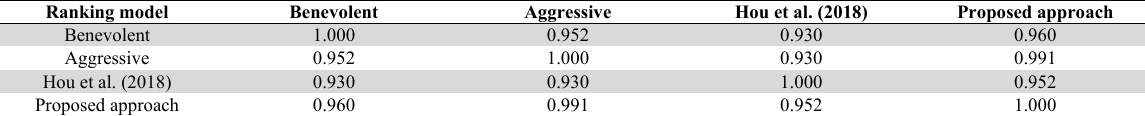
Spearman’s rank correlation test for fourteen international passenger airlines Ranking